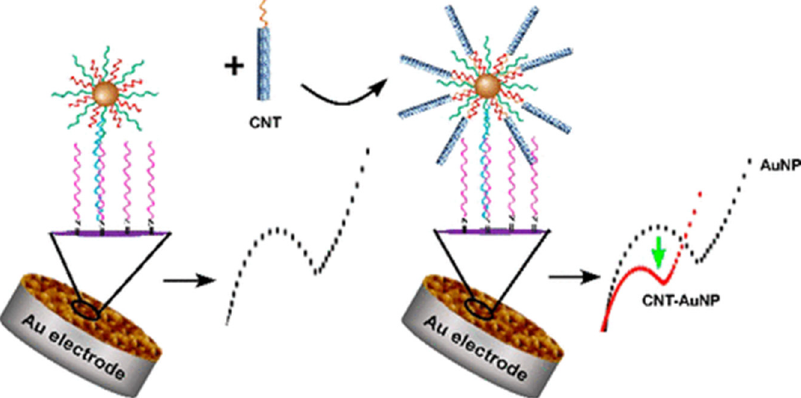
Figure 21. Receptor layer of impidimetric DNA genosensor labelled with urchin-like CNT-AuNPs nanoclusters. Adapted with permission from Han et al. [130] (copyright © (2020), ACS).